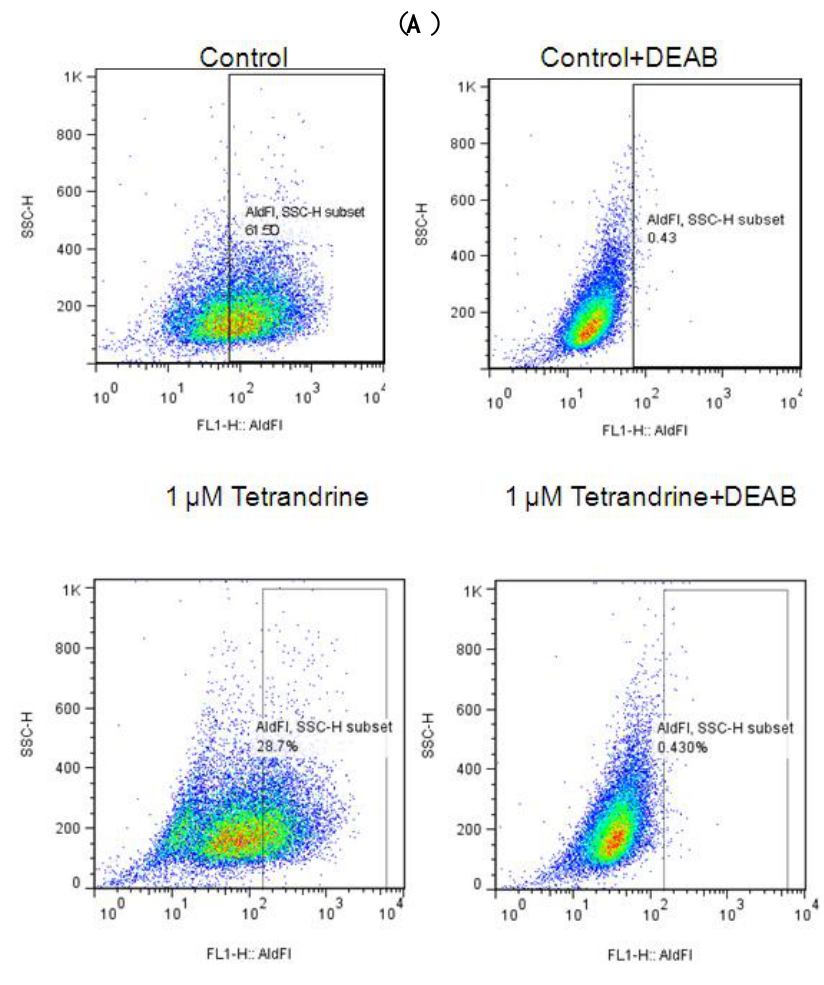
Figure 4. Tetrandrine can decrease ALDH-positive cell population. SUM-159 cells were treated with tetrandrine (1 µM) or vehicle (DMSO) for 4 days and subjected to Aldefluor assay and flow cytometry analysis. ( A ). set of representative flow cytometry dot plots; ( B ). tetrandrine decreased the percentage of ALDH-positive cells (mean of three independent experiments). The error bars represent the standard deviation and Student’s one sided t-test was used for